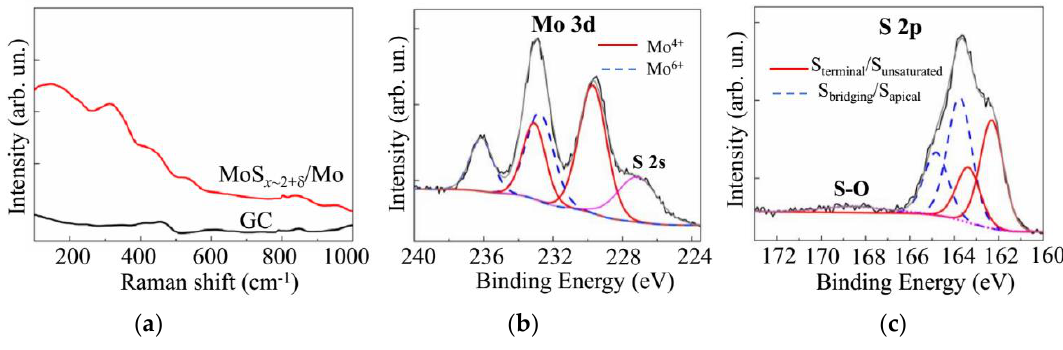
Figure 6. ( a ) Raman spectra for GC substrate, with and without the MoS x ~2+δ /Mo thin film catalyst obtained by on-axis PLD. ( b , c ) XPS spectra of Mo 3d and S 2p, measured on the surface of MoS x ~2+δ /Mo catalyst after prolonged exposure in the air.